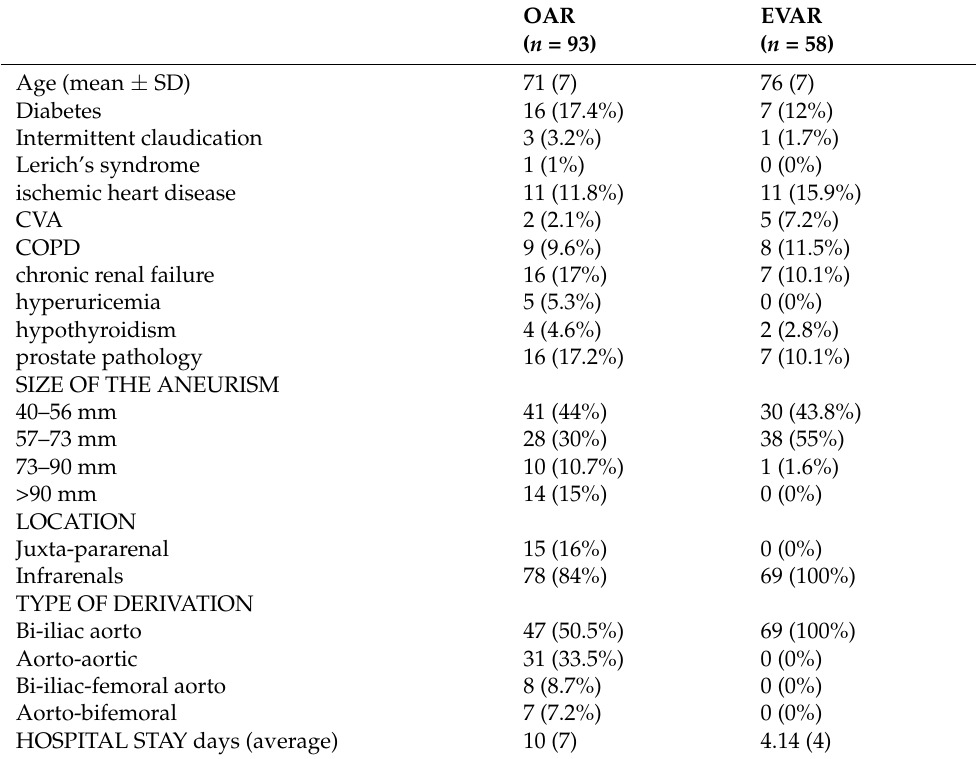
Table 1. Characteristics of the patients receiving intervention and associated pathology. Open abdominal repair (OAR), endoprosthesis abdominal repair (EVAR), cerebral vascular accident (CVA), chronic obstructive pulmonary disease (COPD).